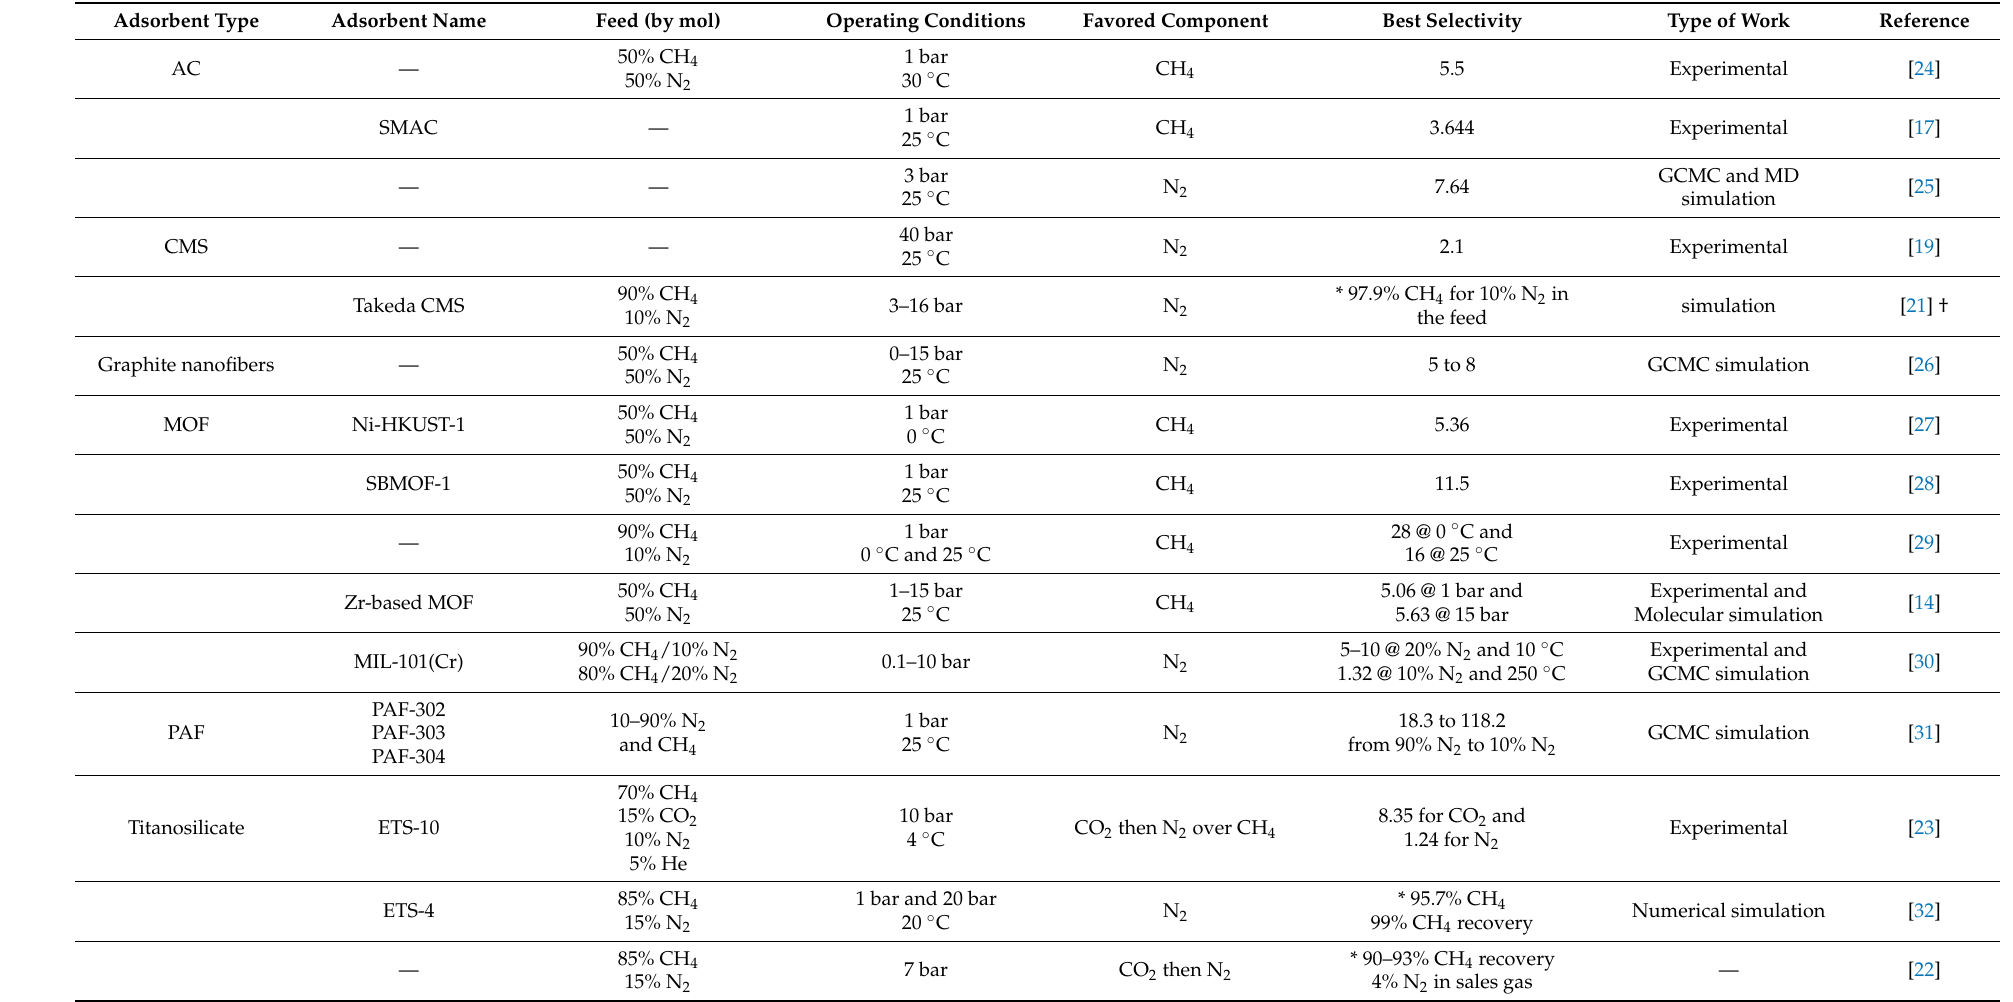
Table 1. Summary of the CH 4 /N 2 separation by